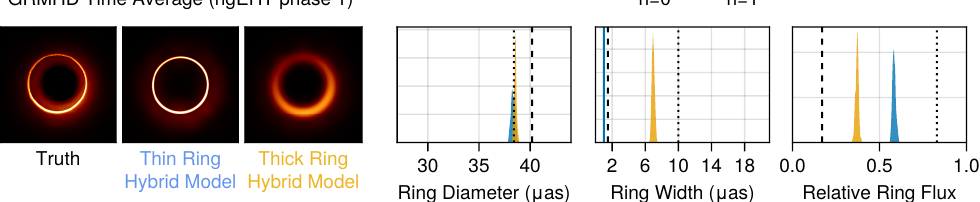
Figure 6. Results of fitting a time-averaged GRMHD simulation with no large-scale jet using a thick ring hybrid model and baseline coverage corresponding to the ngEHT phase 1